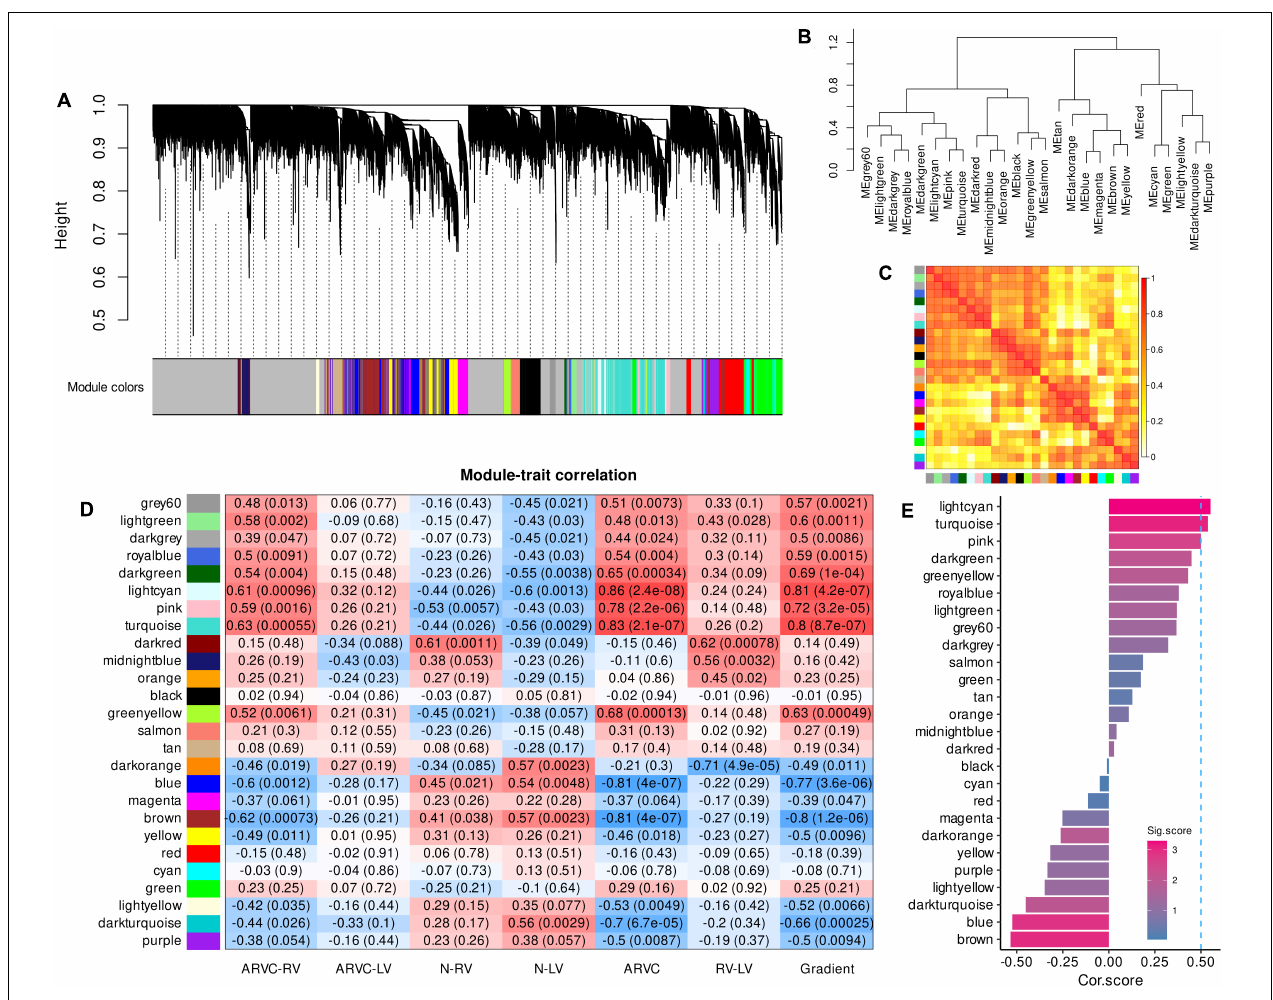
FIGURE 1 | Co-expression gene modules produced by WGCNA and module-trait correlation analysis to select the ARVC hub modules. (A) The dendrogram illustrating modules generated by WGCNA; gray color refers to genes not clustered. (B) The hierarchical clustering tree of modules. (C) The heatmap of eigengene adjacency, darker red color indicated a closer relationship between two modules. (D) Correlations between module eigengenes and seven trait assignments. (E) Cor.score and Sig.score of all modules, modules with Cor.score ≥ 0.5 and Sig.score > 2 are regarded as ARVC hub modules. WGCNA, weighted gene co-expression network analysis; ARVC, arrhythmogenic right ventricular cardiomyopathy; Cor.score, correlation score; Sig.score, significance